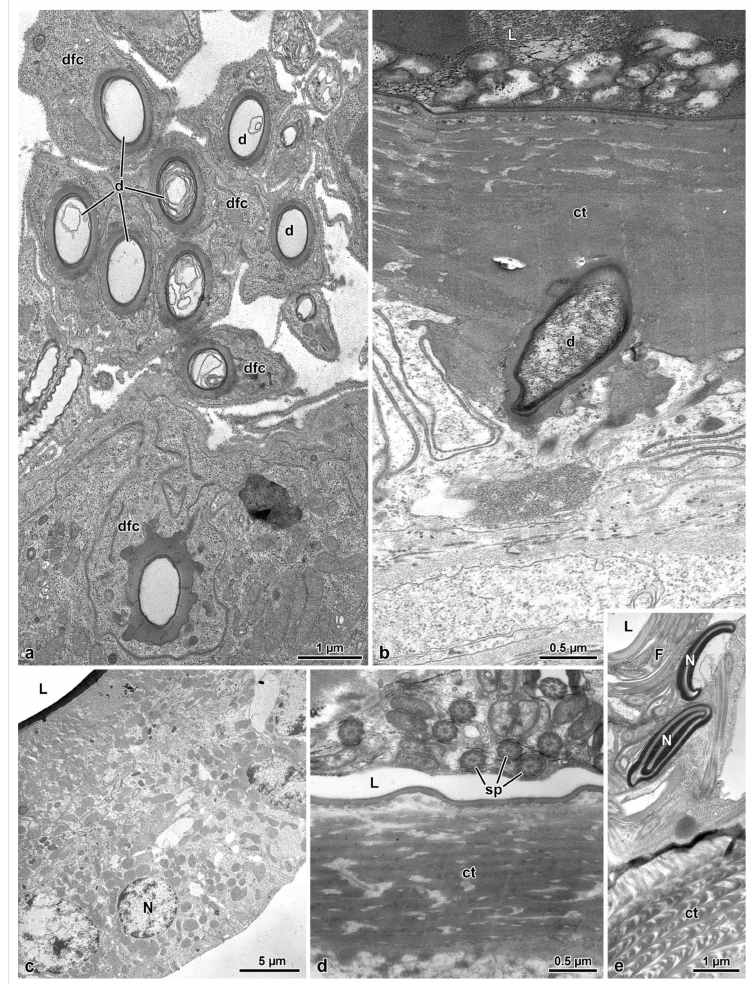
Figure 6. ( a ). Cross section of a complex of duct-forming cells (dfc) with their ducts (d). ( b ). Cross section of the apical region of the spermathecal gland epithelium lined by a thick cuticle (ct) that is crossed by a duct (d) of a duct-forming cell. L, gland lumen. ( c ). Cross section through the spermatheca epithelial cells. L, spermathecal lumen; N, nucleus. ( d , e ). Cross sections through the apical region of the spermatheca to show the lumen (L) filled with sperm cells (sp) sectioned at the flagellar (F) and nuclear (N) levels. ct,